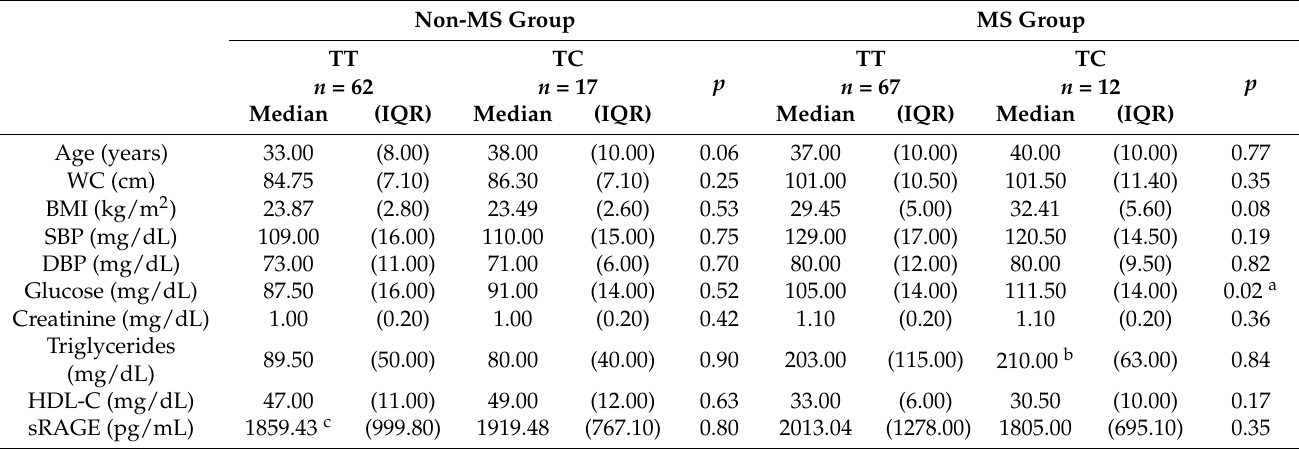
Table 4. Clinical and metabolic variables according to the genotypes of the − 429 T/C polymorphism.